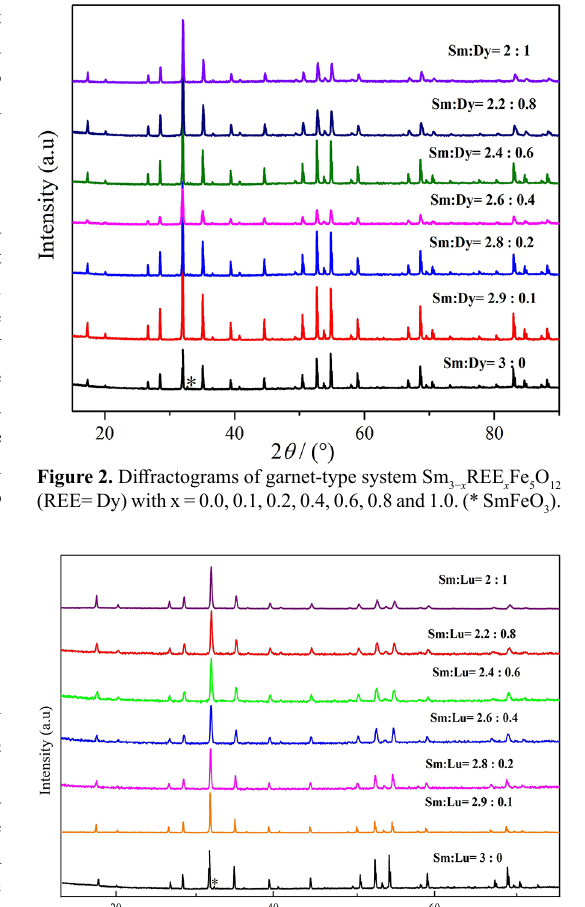
REE Fe O 3− x x 5 12 ). 3